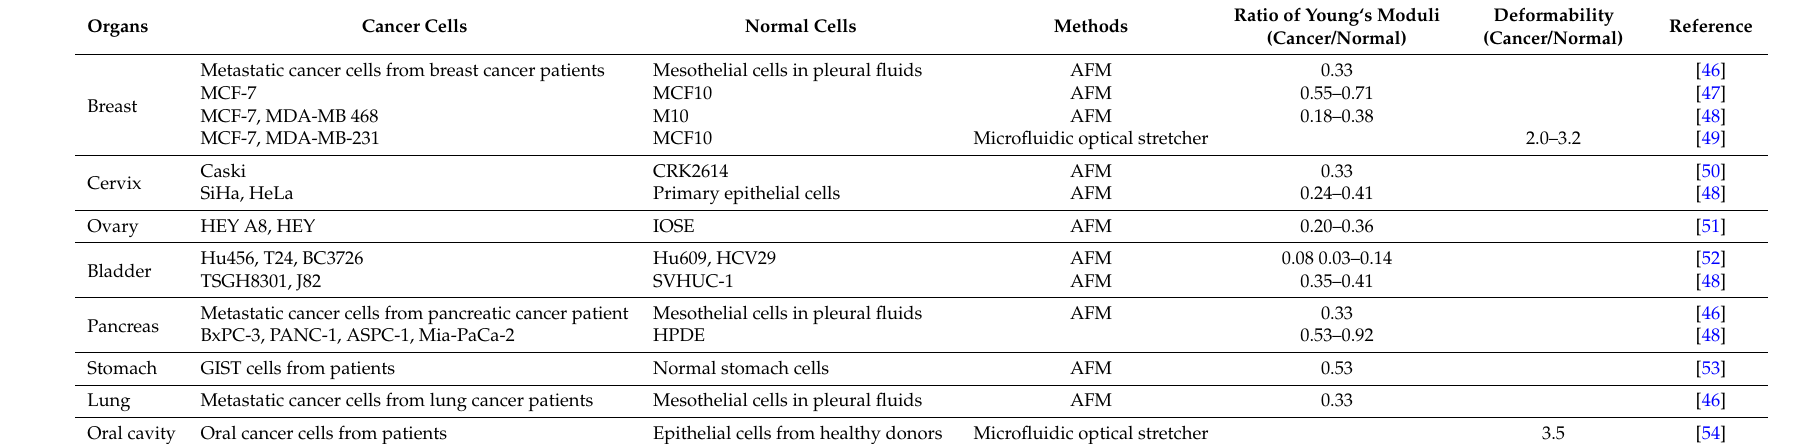
Table 3. Low stiffness as a common biophysical phenotype in various cancer cells.